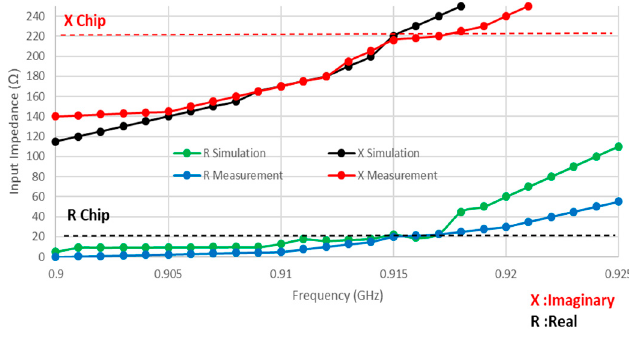
Figure 7. Input impedance of an antenna on a human body.